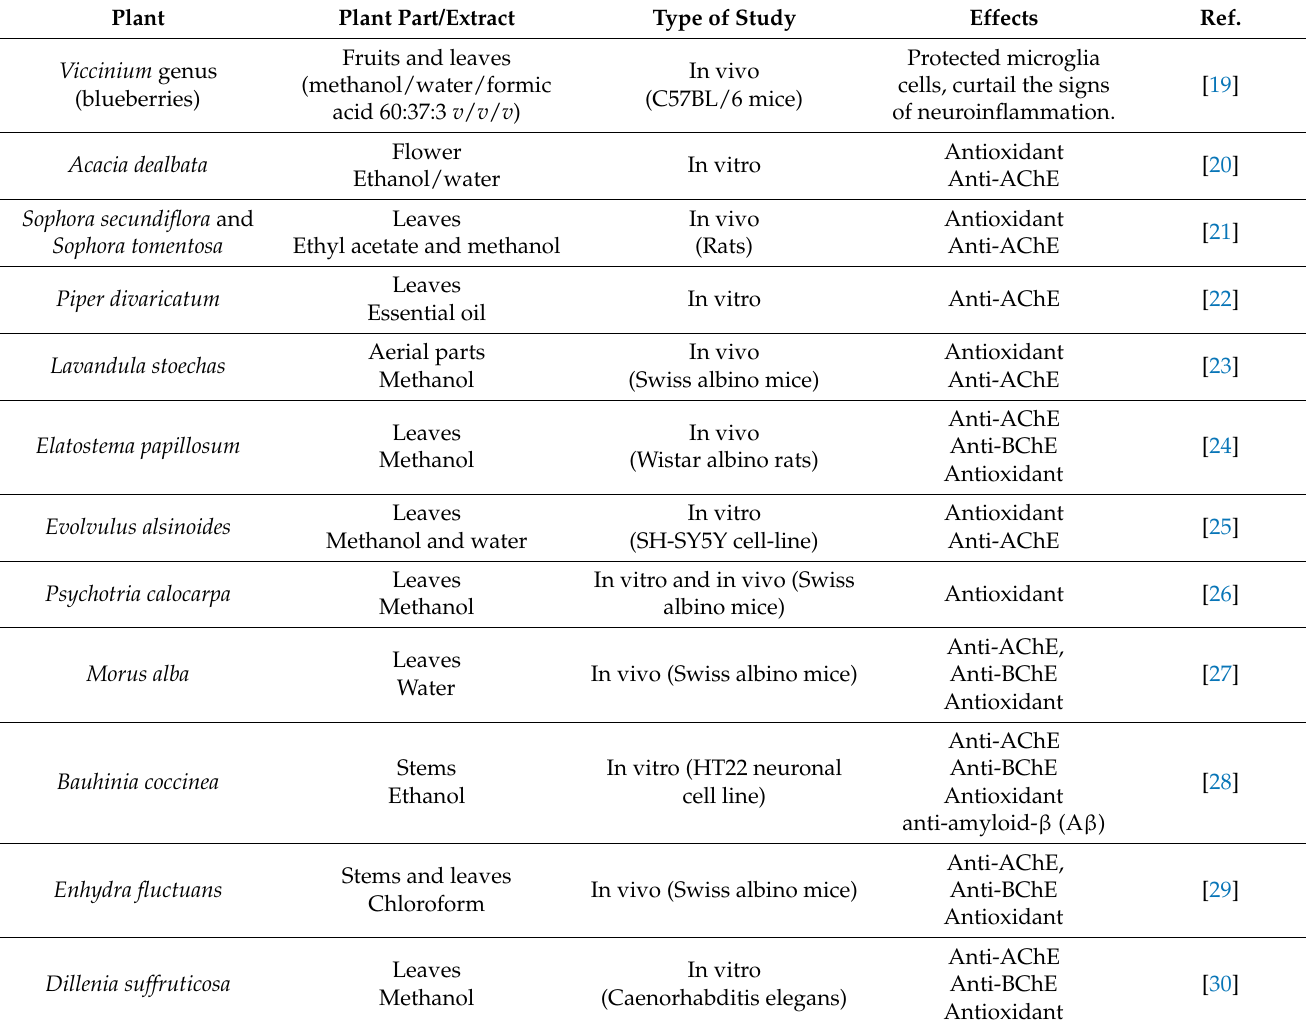
Table 1. In vitro and in vivo effects of several plant extracts in neurodegenerative disorders. Type of Study Effects